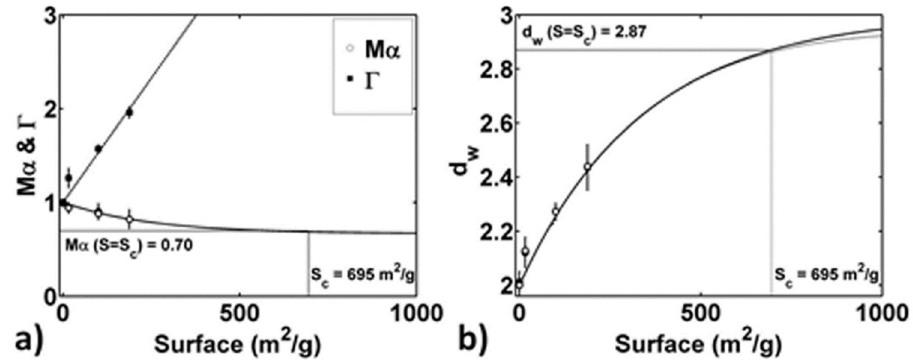
Figure 4. ( a ) mean values of M α distribution belonging to the diffusing water pool interacting with pore walls and the values of Γ scaling exponent estimated from dielectric spectroscopy measurements are reported as a function of the pores surface area, S . Dashed line represents linear trend of data, while straight line represents the exponential decay function: M α = (1 − M α c )exp[ − S / σ ] + M α c fitted to the data. The experimental point at S = 0 and M α = 1 is related to Brownian diffusion of free water. The limiting value of S at the percolation threshold is extrapolated from the fit at M α = M α c = 0.7. ( b ) d w values corresponding to M α values are reported as a function of S . Straight line represents the function: d w = 2/ M α = 2/{(1 – M α c )exp[ − S / σ ] + M α c }, while dashed line represents its Pade approximant: d w = (2 + 2x + x 2 /6)/(1 + x / 2 + x 2 /12) , with x = S / σ . The experimental point at S = 0 and d w = 2 is related to Brownian diffusion of free water. The limiting value of S at the percolation threshold is extrapolated from the fit at d w = 2.87.